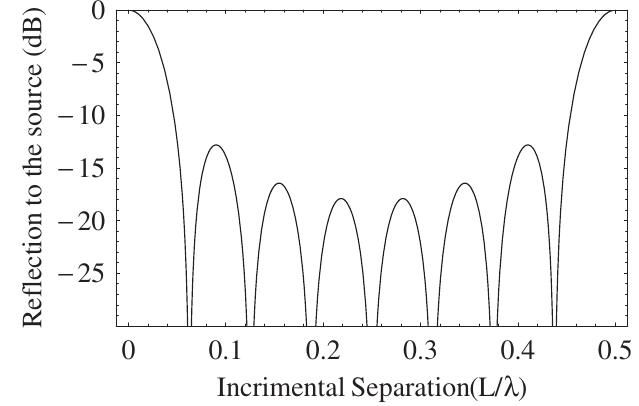
FIG. 3. System response as seen from port 1 of the first directional coupler. The system contains eight accelerator struc- tures and seven directional